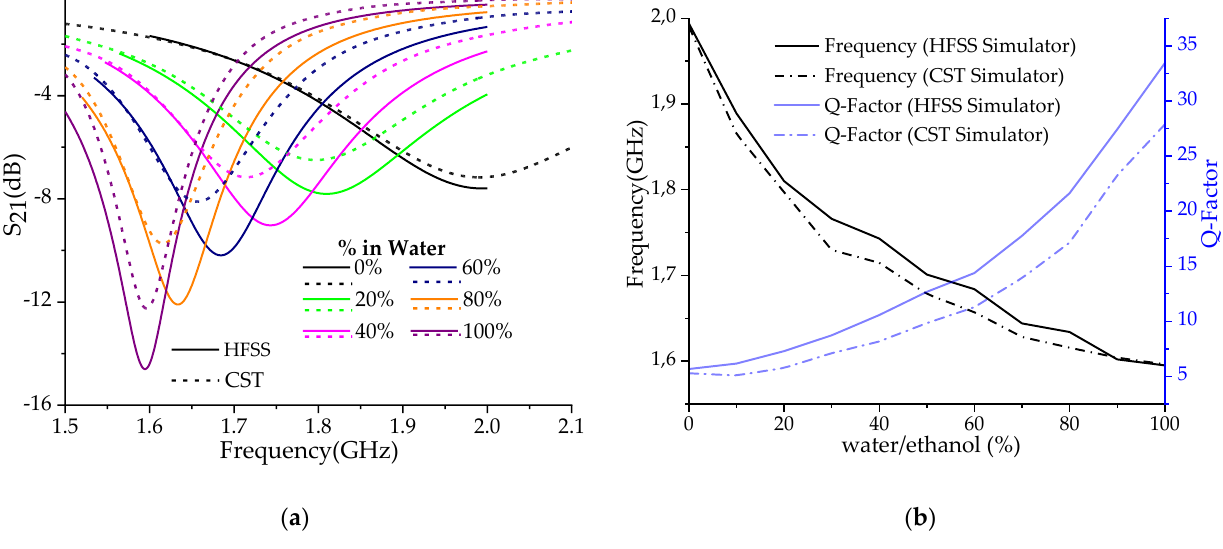
Figure 12. Simulated results: ( a ) S 21 response and ( b ) resonant frequency and Q factor for different mixture water concentrations, with r = 3.75 mm.